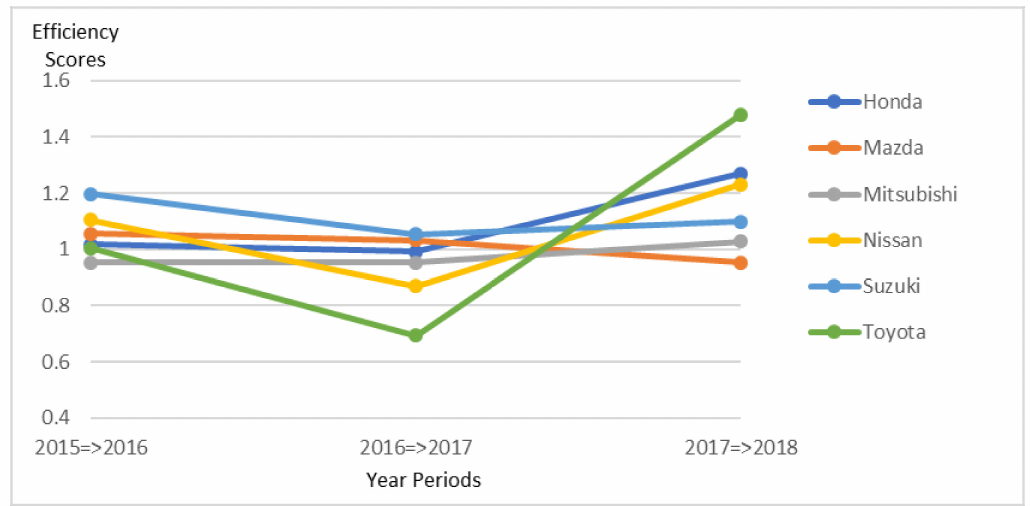
Figure 5. Technical-e ffi ciency changes of Japanese automakers.